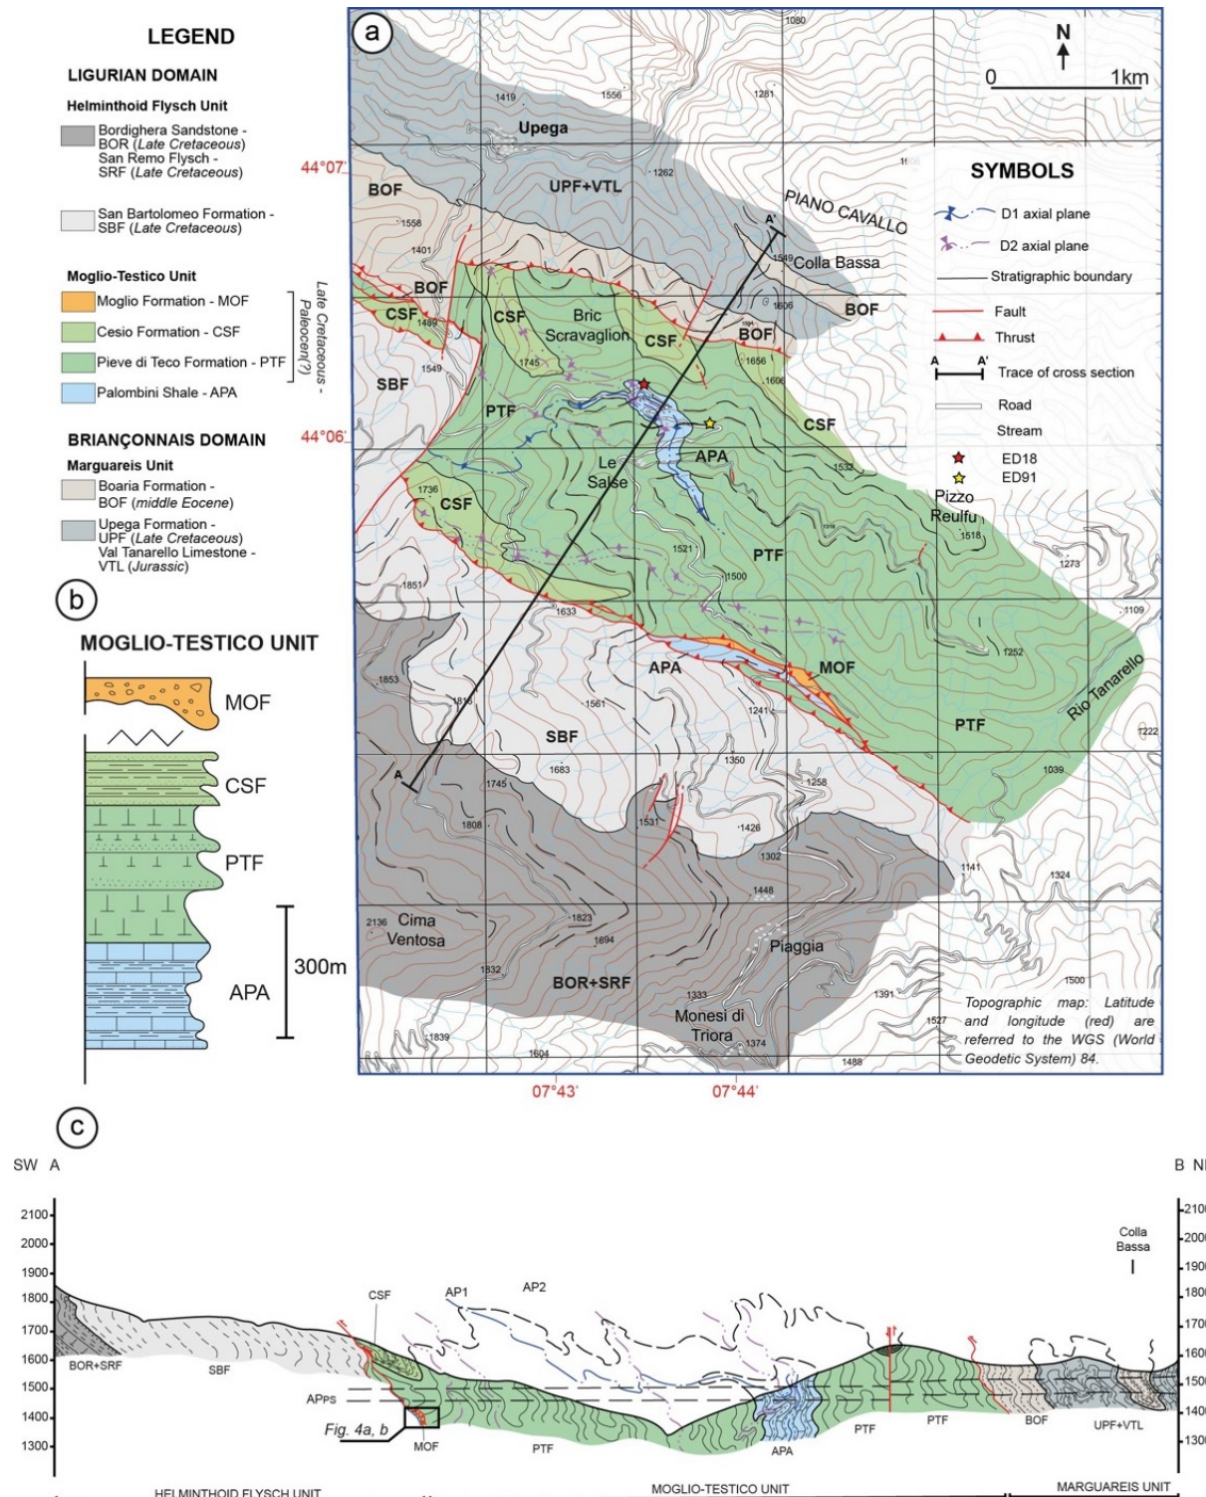
Figure 2. ( a ) Geological map of the study area; ( b ) stratigraphic log of the Moglio-Testico Unit; ( c ) geological cross-section related to the A-A’ trace reported in ( a ). AP1: axial plane trace related to the first deformation phase; AP2: axial plane trace related to the second deformation phase; AP PS : axial plane trace related to the post-coupling fold system.